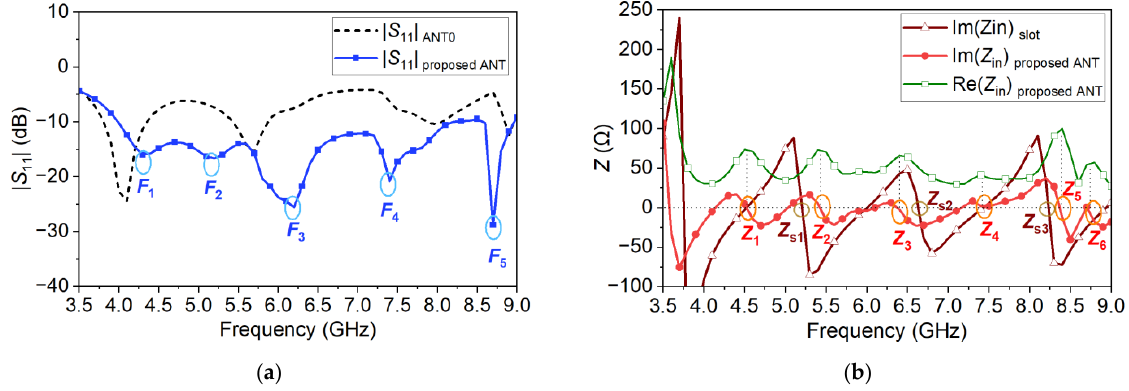
Figure 10. ( a ) Simulated | S 11 | of ANT0 and the proposed antenna. ( b ) Simulated complex impedance of the proposed antenna and the proposed CPW-fed slot.